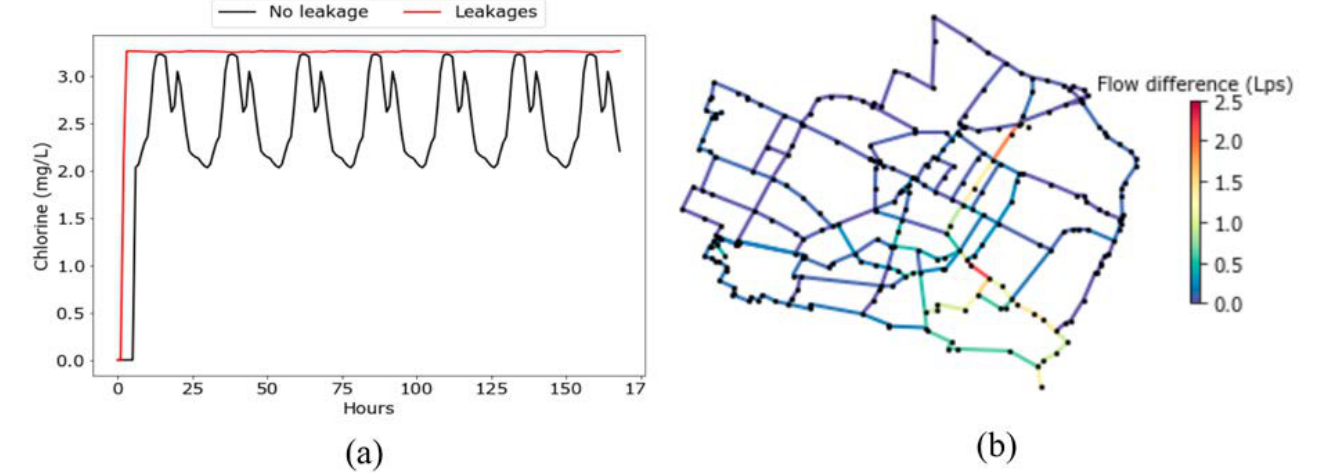
Figure 10. Behavior of quality and flow with leakage 133: ( a ) chlorine—node 104 and ( b ) flow differences—leakage node